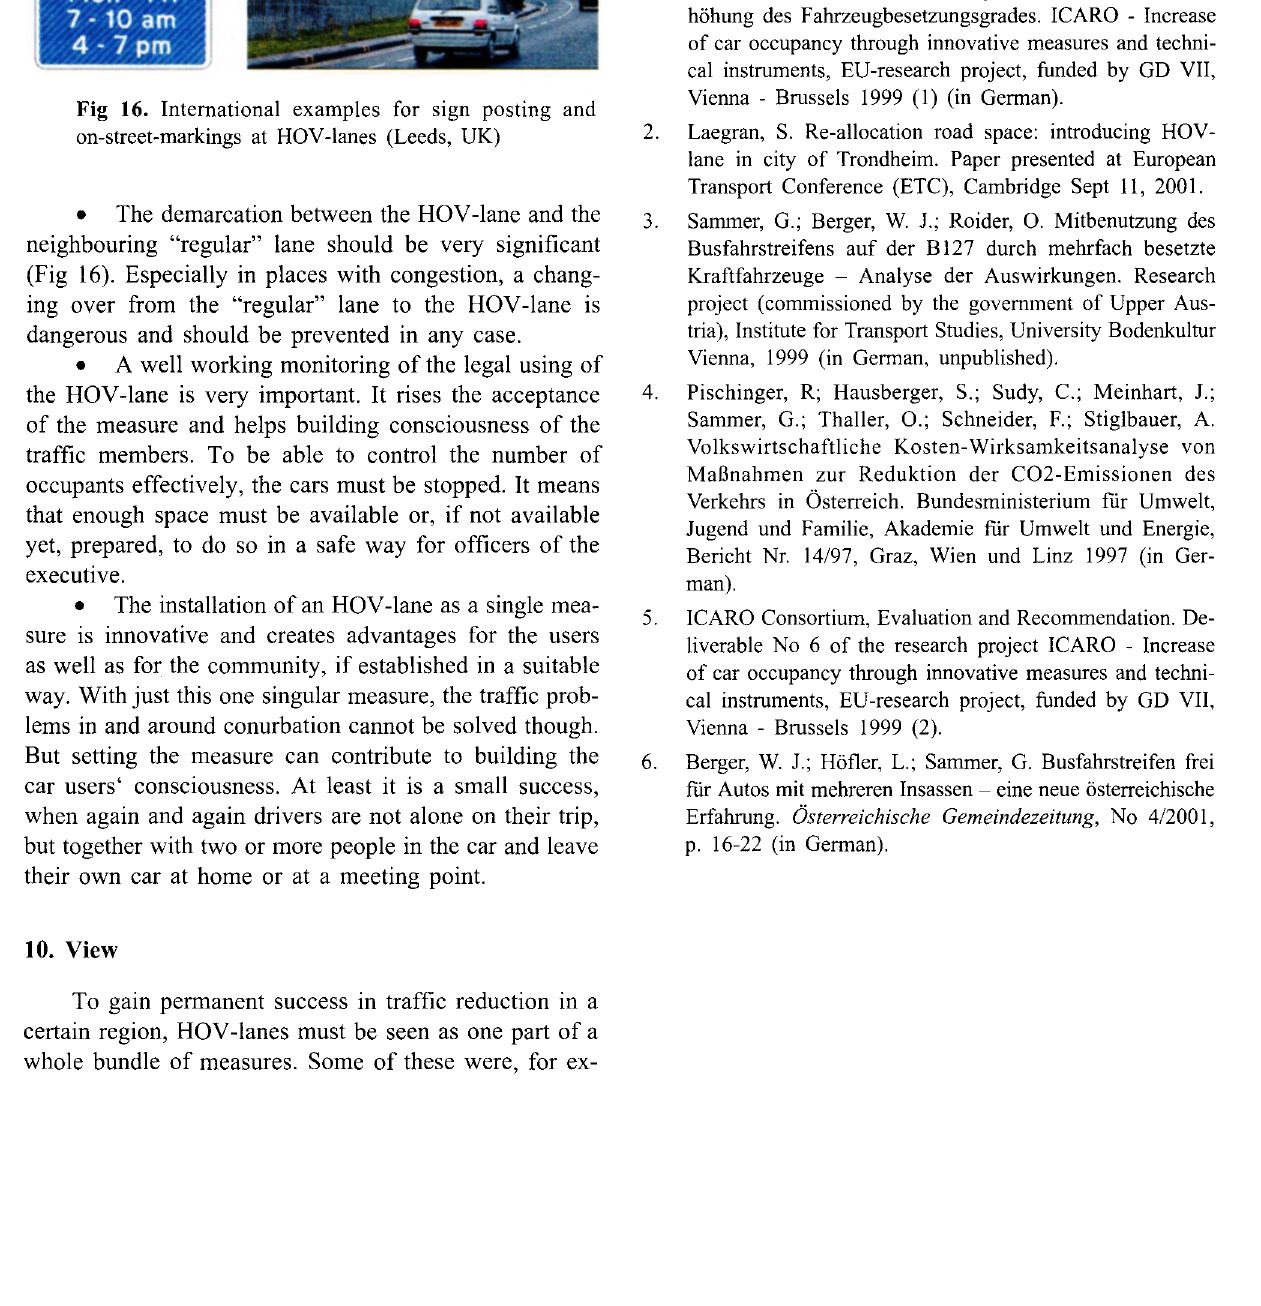
Fig 16. International examples for sign posting